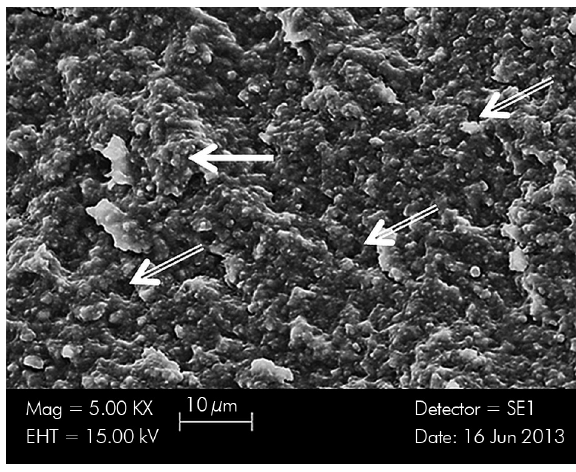
Figure 3. SEM image (5000x) of the fracture surface of the BFS-initial specimen of the 0.4-1 group. Double-trace arrows: sites where particles became detached; single-trace arrow: filler covered by resin